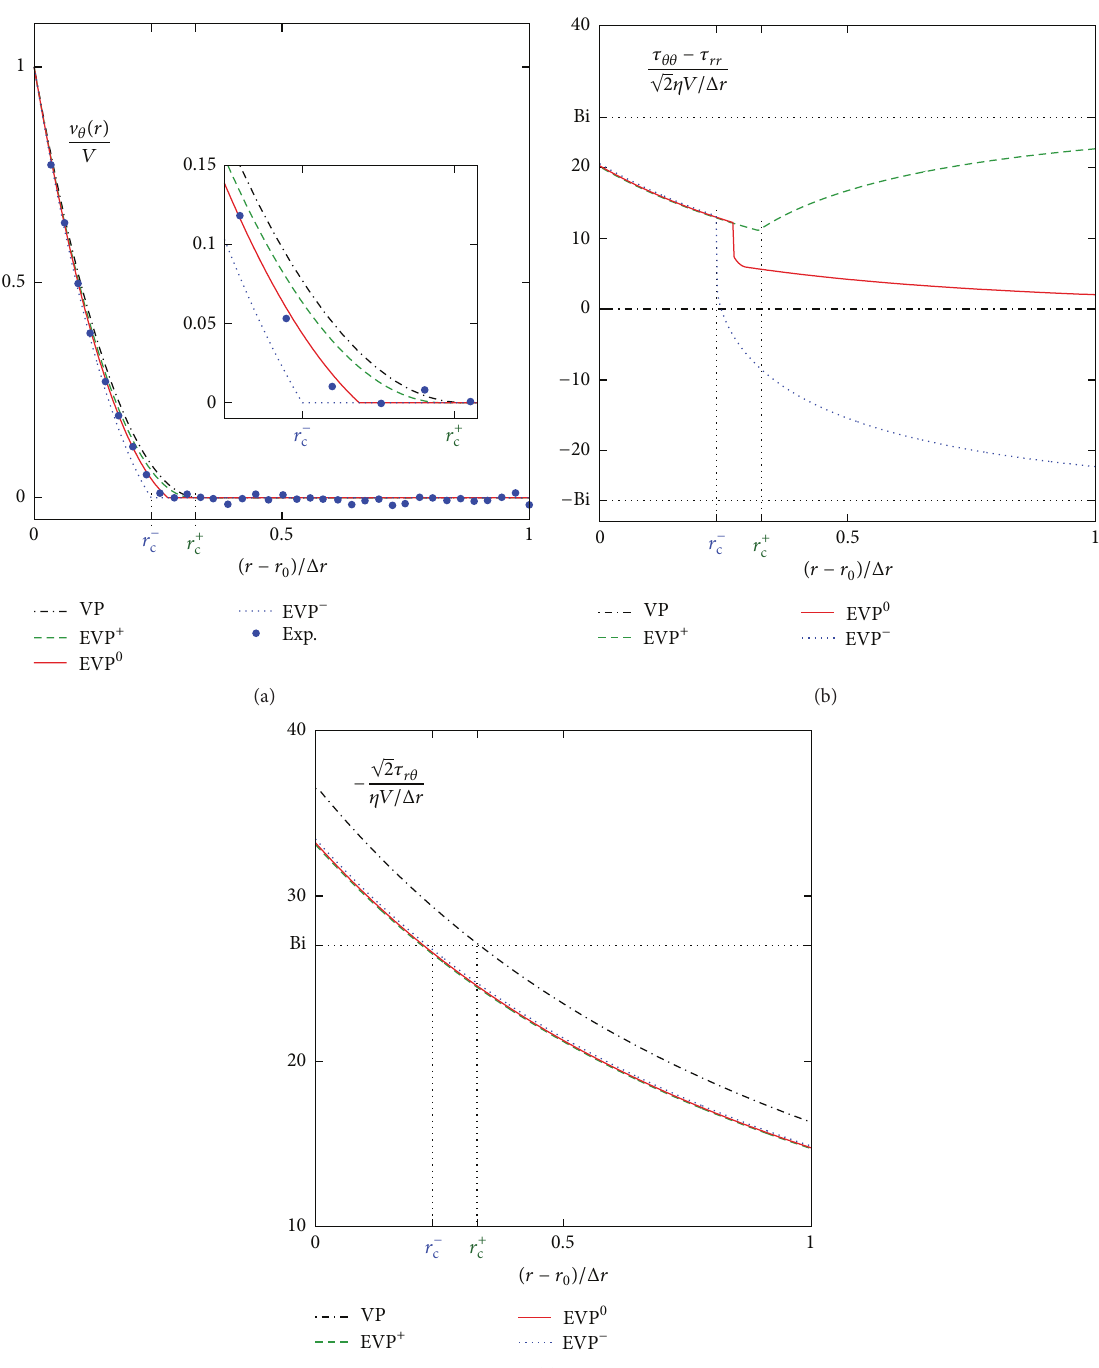
Figure 10: Comparison between the steady-state solutions of the viscoplastic (VP) Herschel – Bulkley model and the elastoviscoplastic (EVP) Saramito model in cylindrical Couette geometry with different residual stresses: (a) velocity, with experimental data (exp.) for a natural bentonite suspension (from [136]); (b) normal stress; (c) shear stress. Lines: solutions of the EVP model with different initial stress conditions. Thick solid line (EVP 0 ): 𝜏 𝜃𝜃 = 0 ; thin dashed line (EVP + ): 𝜏 𝜃𝜃 = + √ 2𝜏 y ; thin dotted line (EVP − ): 𝜏 𝜃𝜃 = − √ 2𝜏 y ; thick dash-dotted line (VP). 𝑟 c represents the critical radius for flow. (Reprinted with permission from Cheddadi et al. [92]. Copyright 2012, The Society of